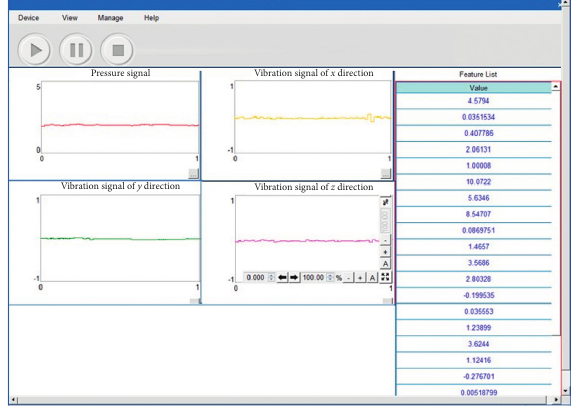
Figure 10: Data acquisition system based on